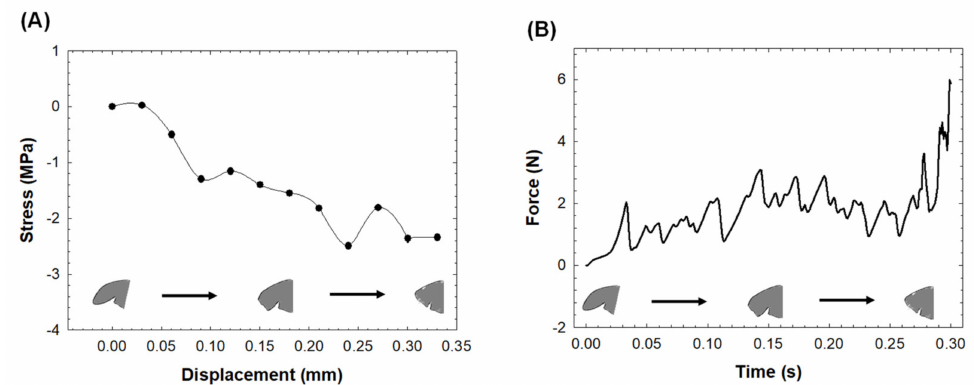
Figure 4. ( A ) Average stress at LAA tip as a function of displacement of the clamped nodes: ( B ) pulling force needed for LAAI as a function of simulation